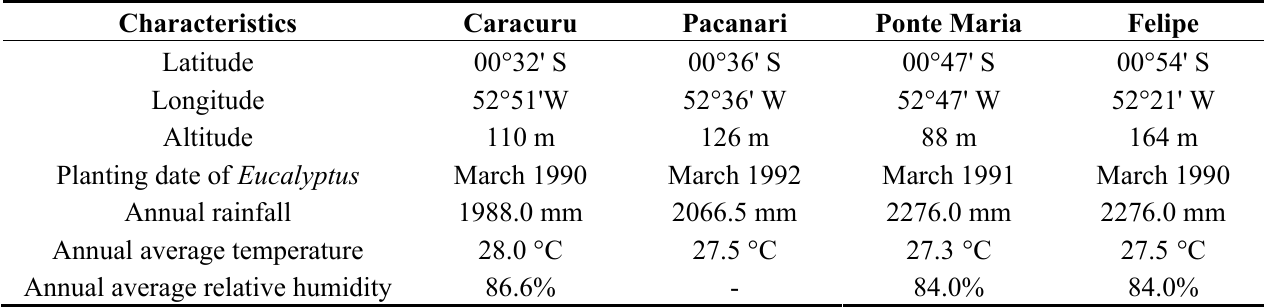
Table 1. Sampling sites in Caracuru, Pacanari and Ponte Maria, Pará State and Felipe, Amapá State,